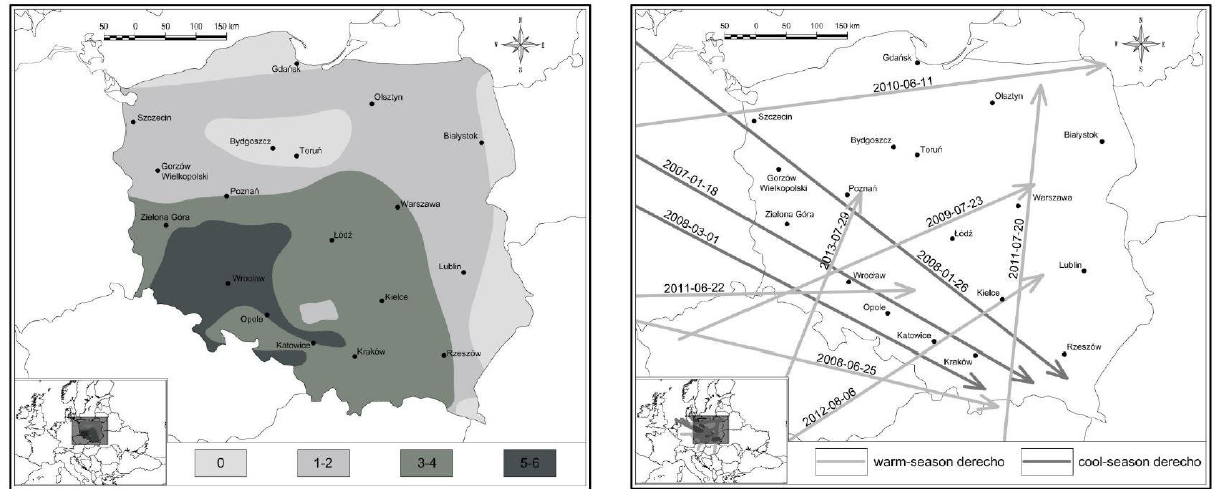
Fig. 1. The occurrence of derecho phenomenon (left) and the movement tracks of the MCC (right) between 2007 and 2014 in Poland. Source: Celiński-Mysław, 2015